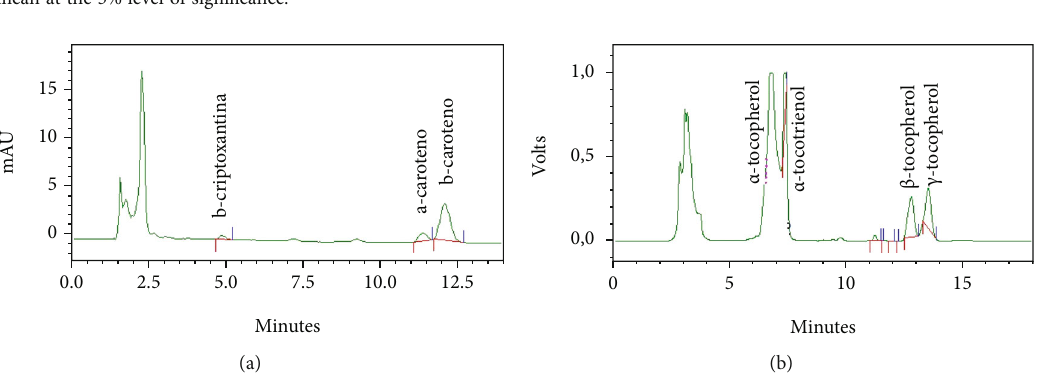
Figure 2: Chromatographic pro fi le of carotenoids (a) and vitamin E (b) in S. arvensis